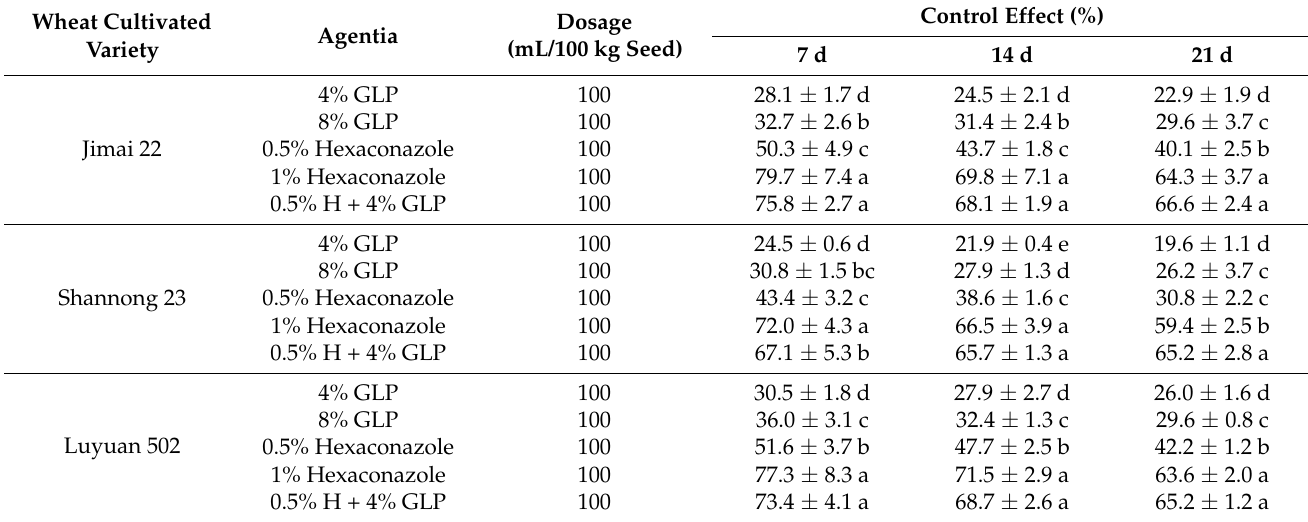
Table 9. Control effect of the seed treatment on wheat sharp eyespot.